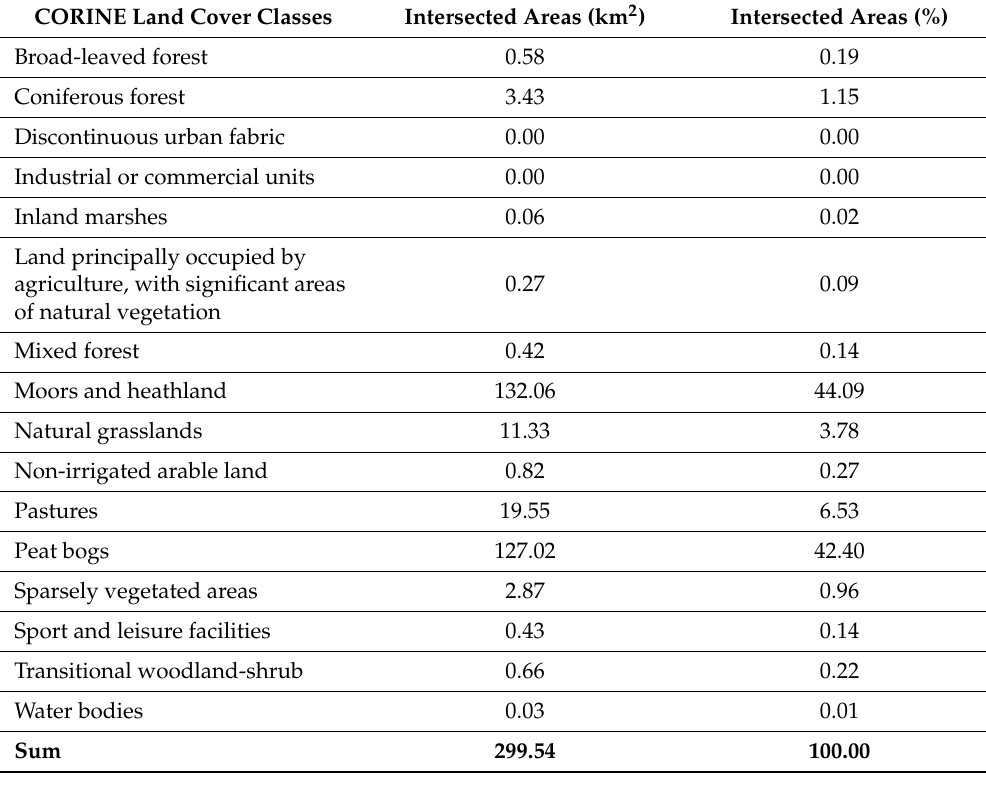
Table 2. Intersected areas between CLC polygons and the polygons of the suitable areas for floodplain woodland planting.